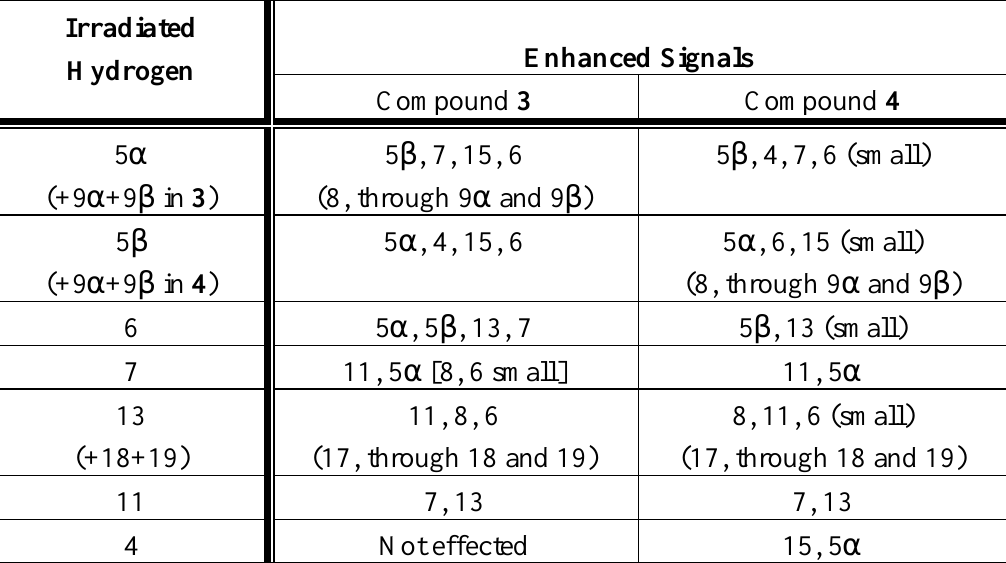
Table 4. Nuclear overhauser effect on isomers 3 and 4